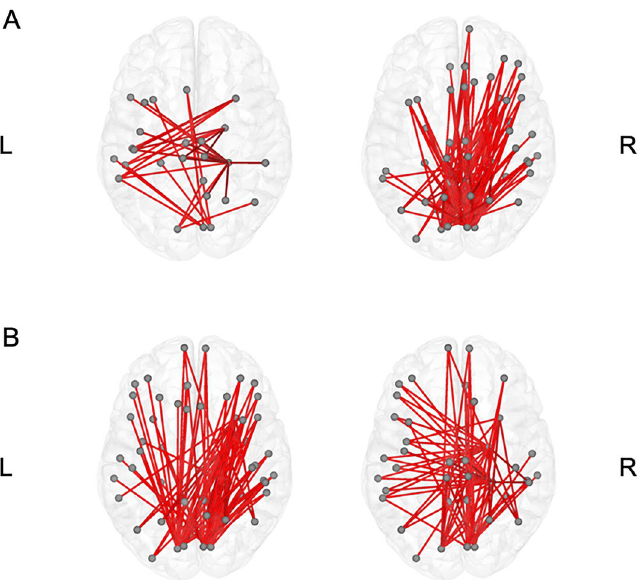
Figure 3. Beta2 band network from edge wise analysis. Beta2 band network from edge wide analysis of the control group ( A ) and treatment group ( B ). Baseline network in left side and 48-week network in right side. The treatment group ( B ) showed significant increase of nodal degree at the right entorhinal cortex, temporal pole and parahippocampal cortex, and decrease of nodal degree at the bilateral pericalcarine cortex and right cuneus as opposed to control group ( A ). L Left, R